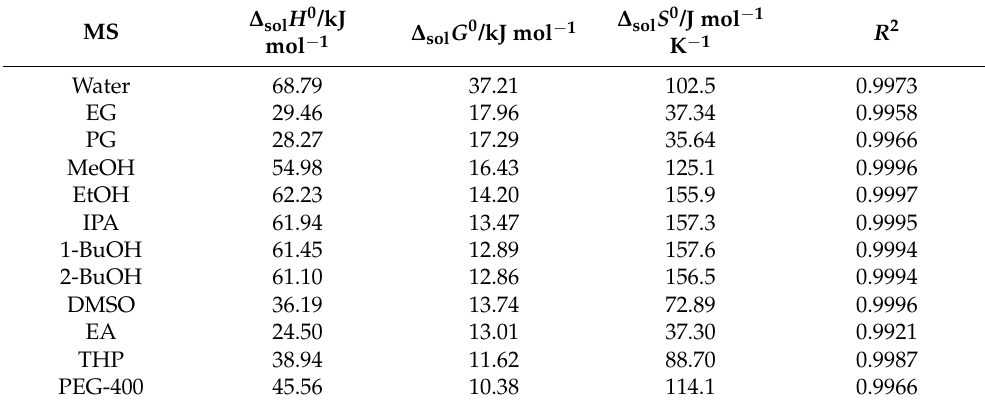
Table 7. Apparent thermodynamic parameters ( ∆ sol H 0 , ∆ sol G 0 , and ∆ sol S 0 ) along with R 2 values for FBX in numerous MS a